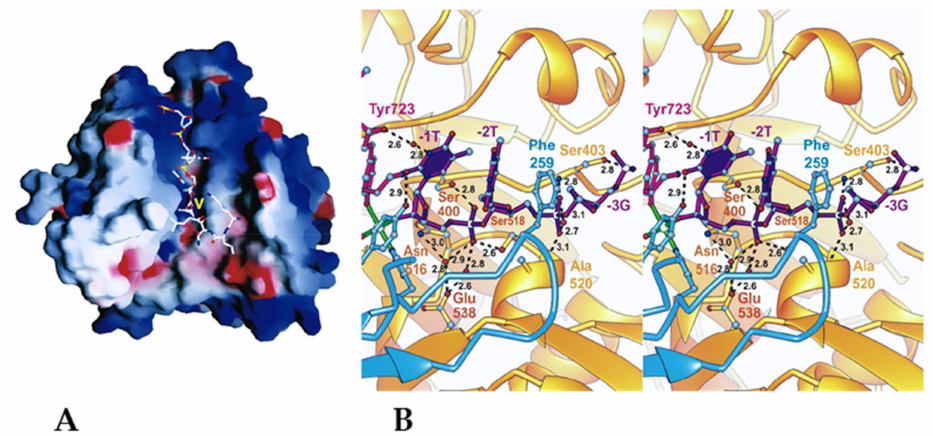
Figure 1. Crystal structure of the complex of TDP1 with the vanadate oxoanion VO 43 − [6]. ( A ) Red depicts a negative partial charge on the surface, blue depicts positive partial charge. The yellow V indicates the position of the vanadate residue in the active site. The DNA moiety extends above the active site, bound in the narrow, positively charged half of the substrate-binding groove. The peptide moiety is located below the active site, in a relatively neutral part of the wider substrate-binding cleft (Protein Data Bank (PDB) ID: 1NOP). ( B ) Detailed view of contacts between the substrate and amino acid residues in the catalytic site of TDP1. H-bonds between DNA and amino acid residues of TDP1 are